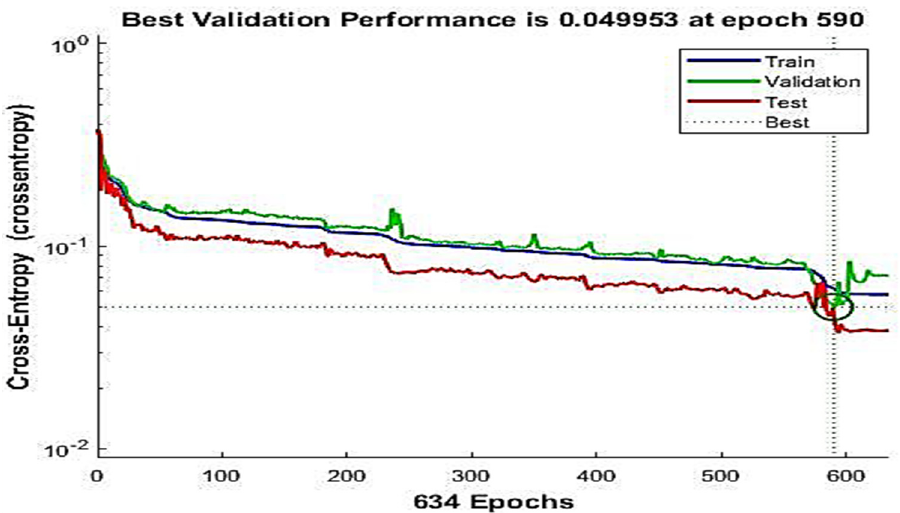
Figure 10. Graph of performance during training.